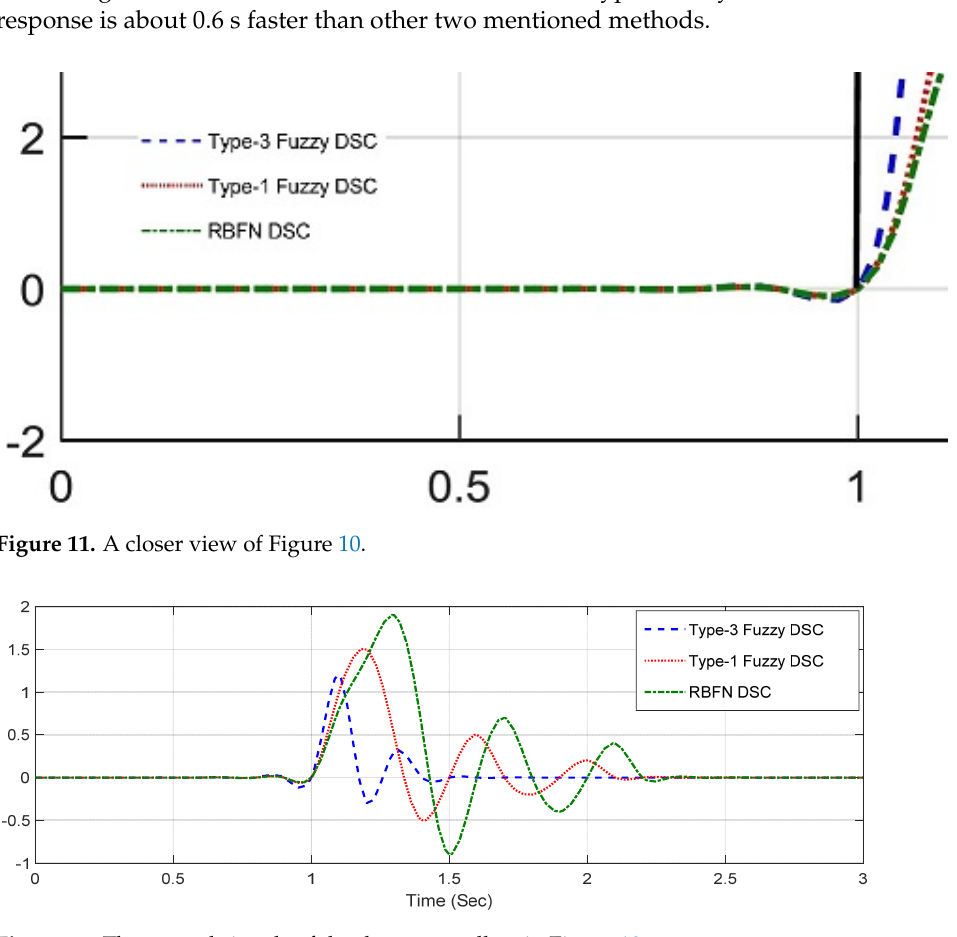
Figure 12. The control signals of the three controllers in Figure 10.